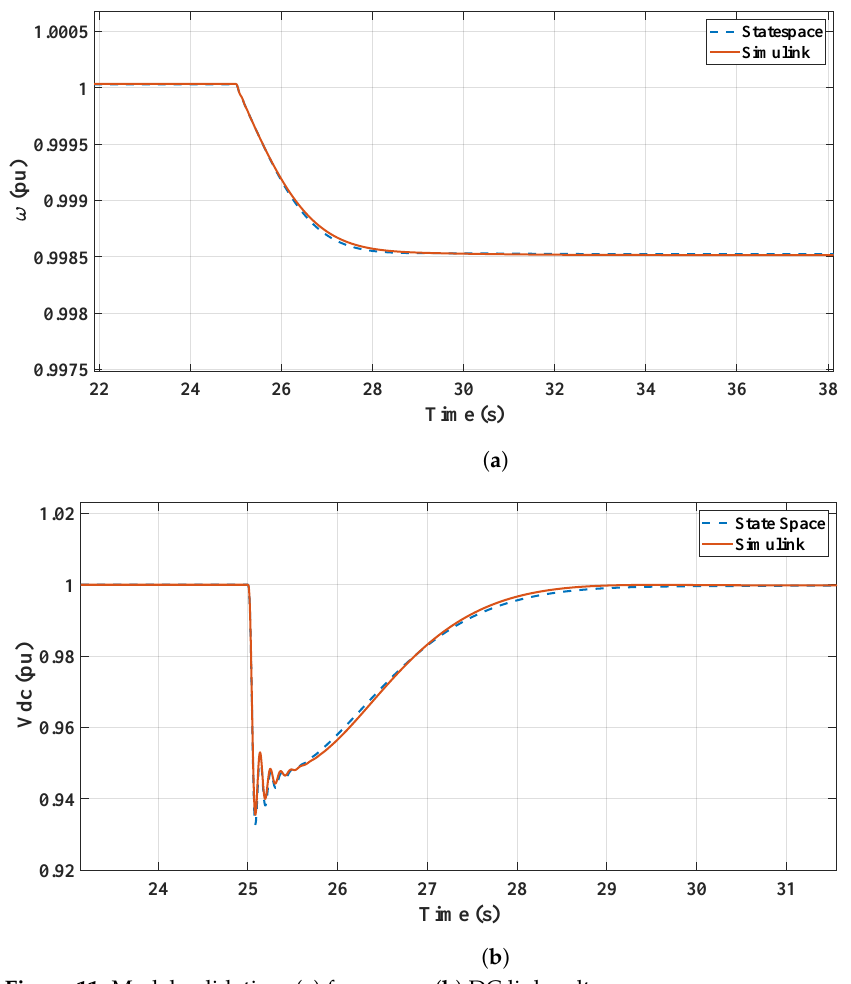
Figure 11. Model validation: ( a ) frequency, ( b ) DC link